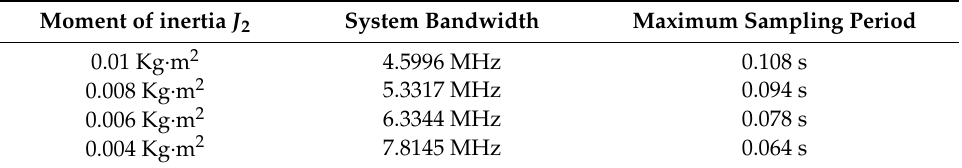
Table 2. Required system